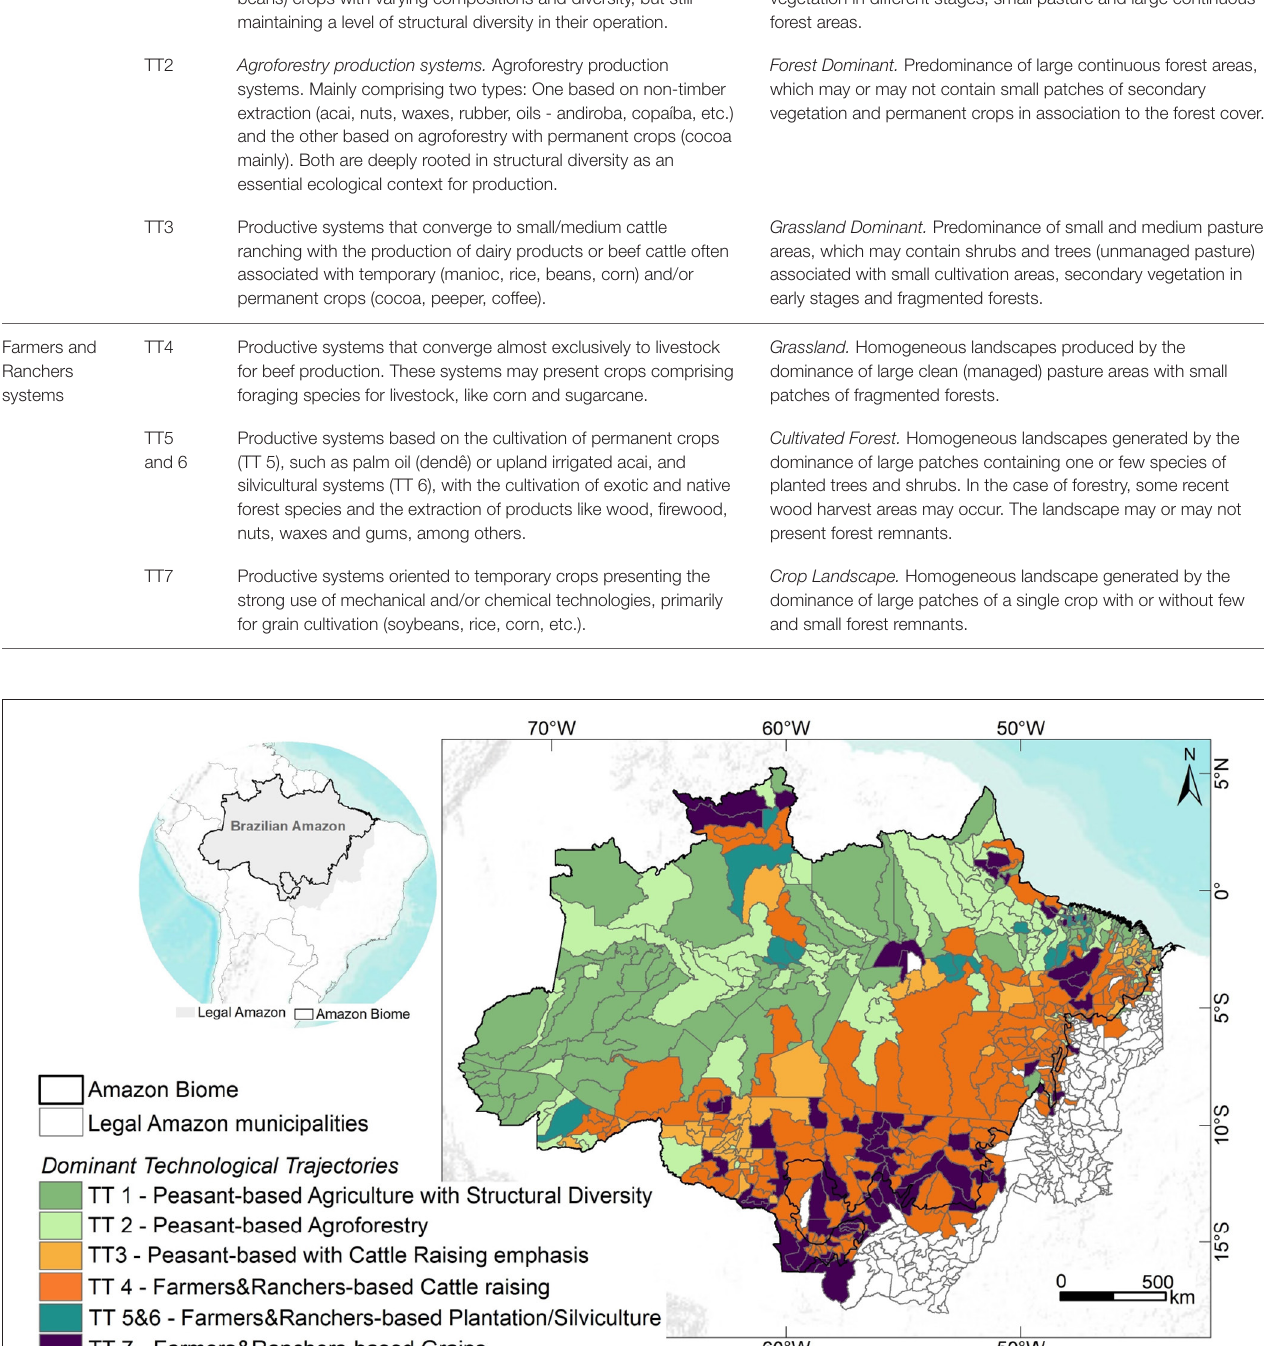
Frontiers in Public Health |